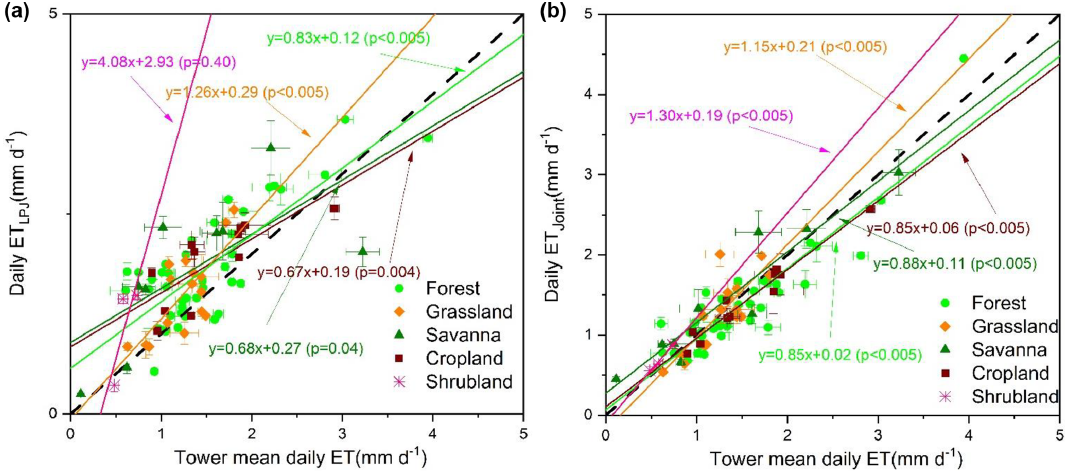
Figure 7. Scatter plots of daily ET LPJ (a) and daily ET joint (b) versus tower ET for different PFTs.